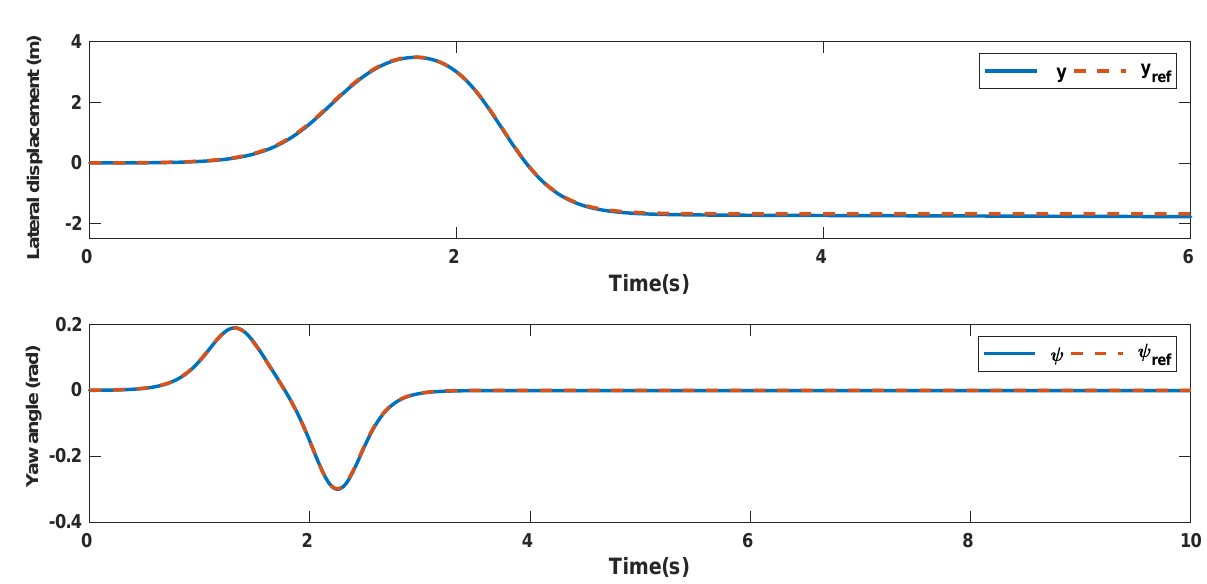
Figure 8. Lateral displacement and Yaw angle, with ϑ x = 20 m/s.